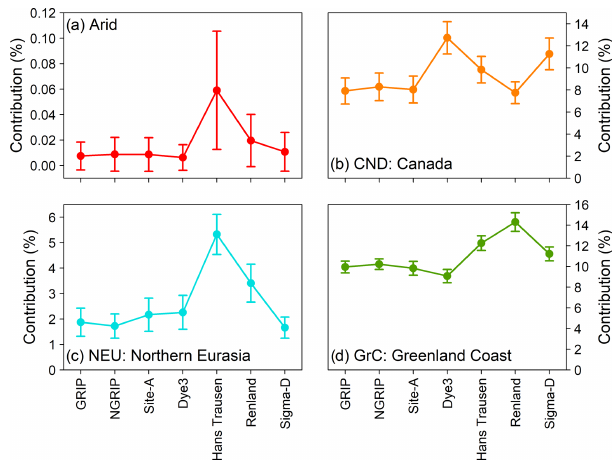
Figure 11. Air mass contribution for the 7d back trajectory from (a) arid regions (China, Central Asia, and the Middle East), (b) North America (Canada and US), (c) Eurasia (EU and Russia), and (d) the Greenland coast at the seven ice core sites on Green- land. Error bars indicate the standard deviation of contributions from 1981 to